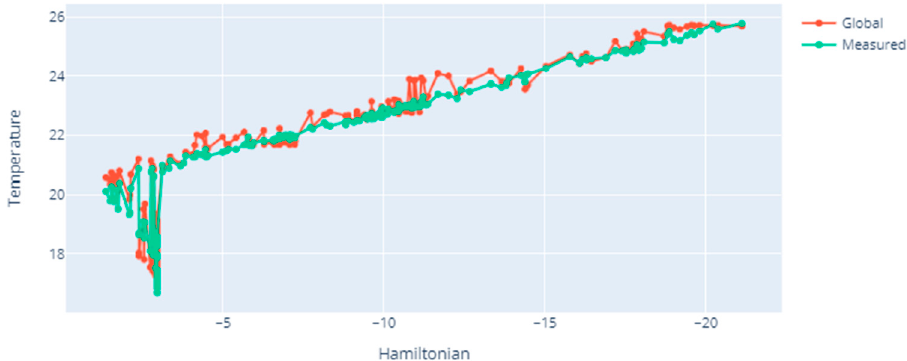
Figure 8. Dependence of Hamiltonian value on temperature.